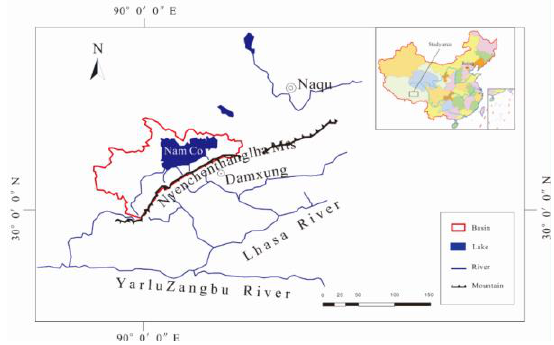
Figure 1. Location of Nam Co